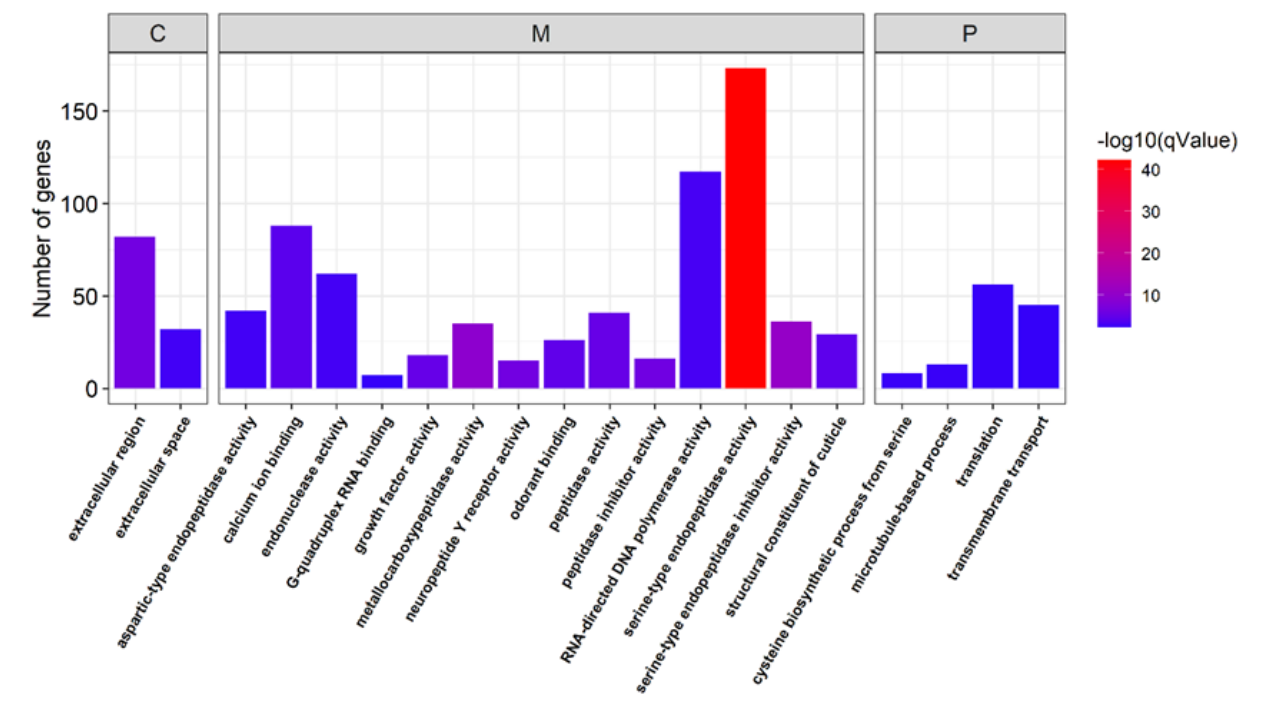
Figure 5. Gene ontology classification of the male-biased genes. C: cell component; M: molecular function; P: biological process.